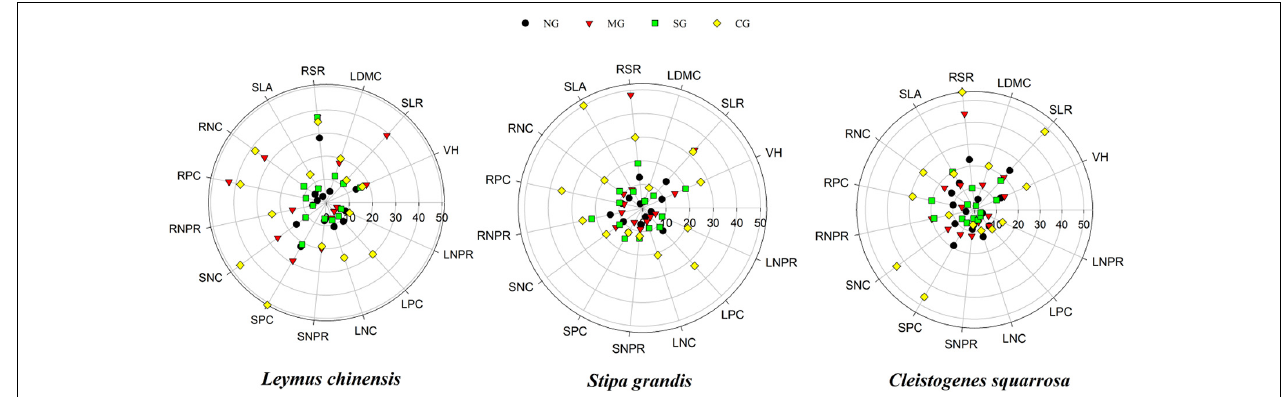
FIGURE 4 | Polar figure of ITV in dominant species at each plot. Plot NG means no grazing; plot MG means mixed grazing of cattle and sheep; plot SG means grazing sheep alone and CG means grazing cattle alone. VH indicates vegetative height, SLR indicater stem-to-leaf ratio, LDMC indicate leaf dry matter content, RSR indicate root biomass over above-ground biomass, SLA indicate specific leaf area, RNC indicate root nitrogen content, RPC indicate root phosphorus content, RNPR indicate root nitrogen to phosphorus ratio, SNC indicate stem nitrogen content, SPC indicate stem nitrogen content, SNPR indicate stem nitrogen content, LNC indicate leaf nitrogen content, LPC indicater leaf phosphorus content, LNPR indicate leaf nitrogen phosphorus